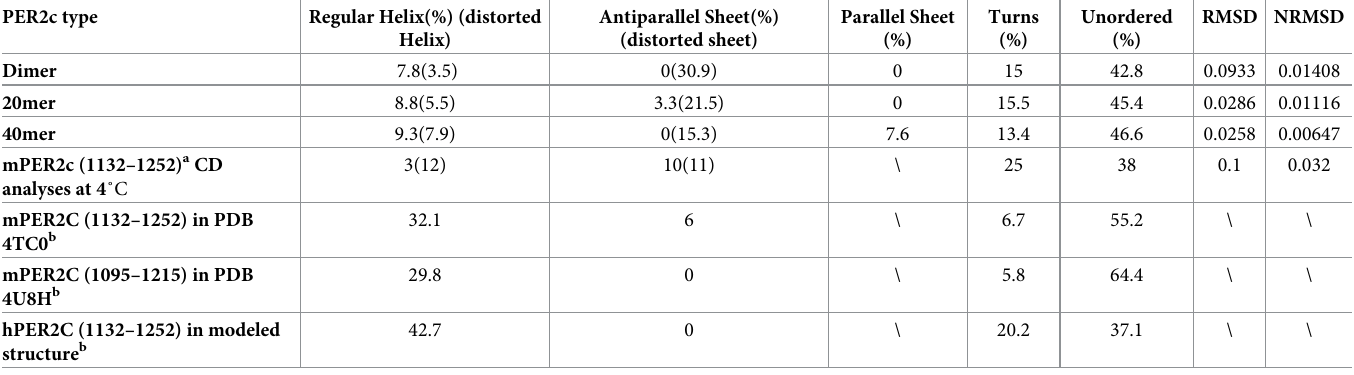
Table 2. The secondary structure compositions of all three hPER2c forms estimated from their CD spectrum by BeStSel, in comparison to previous measurement and crystal structures. PER2c